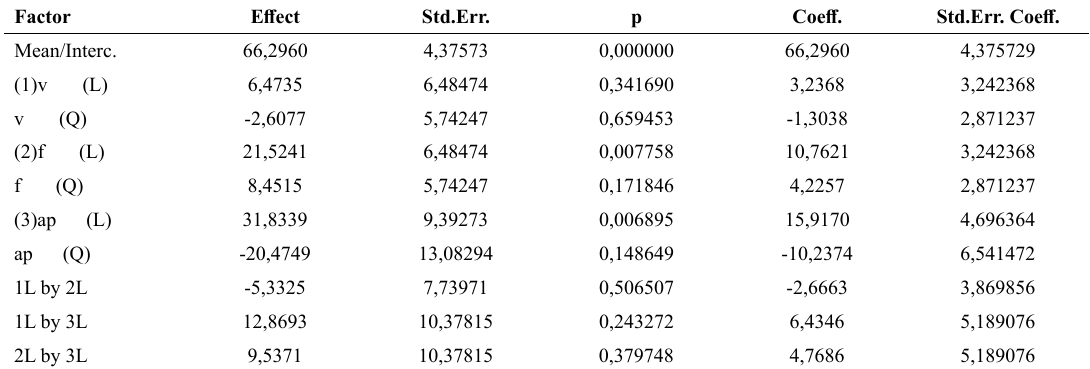
Table 6. ANOVA for the effect of the independent variables on cutting force. Factor Effect Std.Err. p Coeff. Std.Err. Coeff.